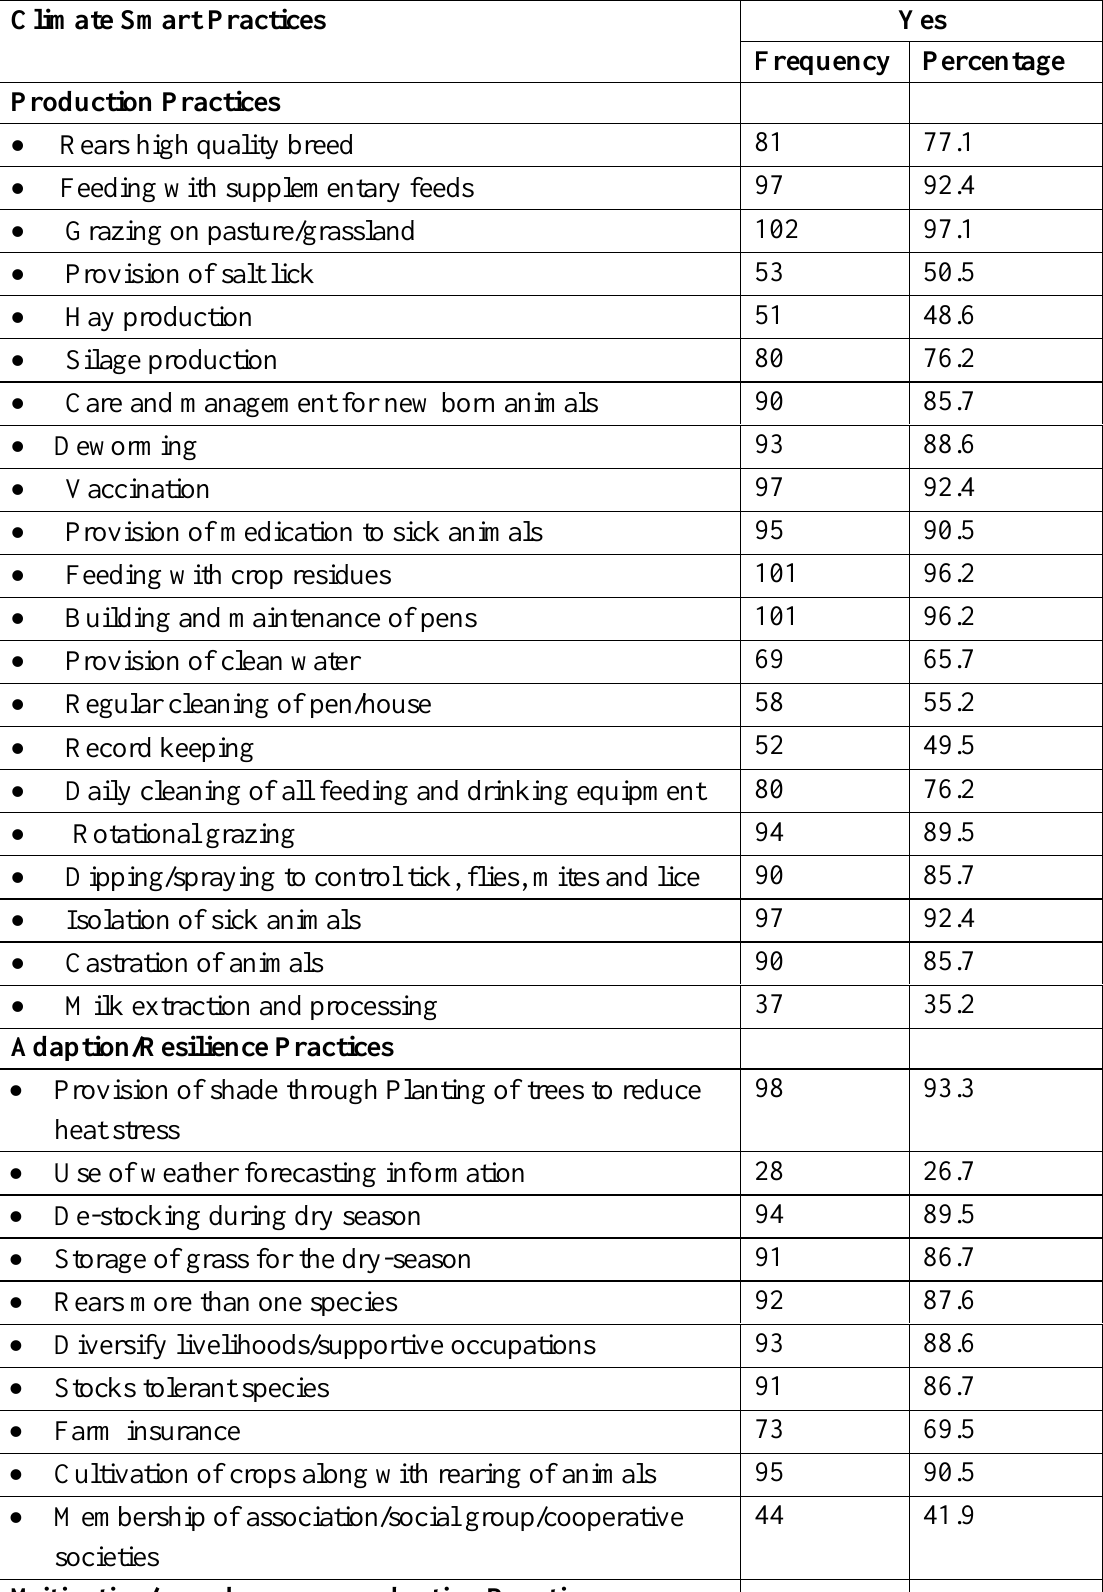
Table 2. Climate smart small ruminant production practices used among respondents Climate Smart